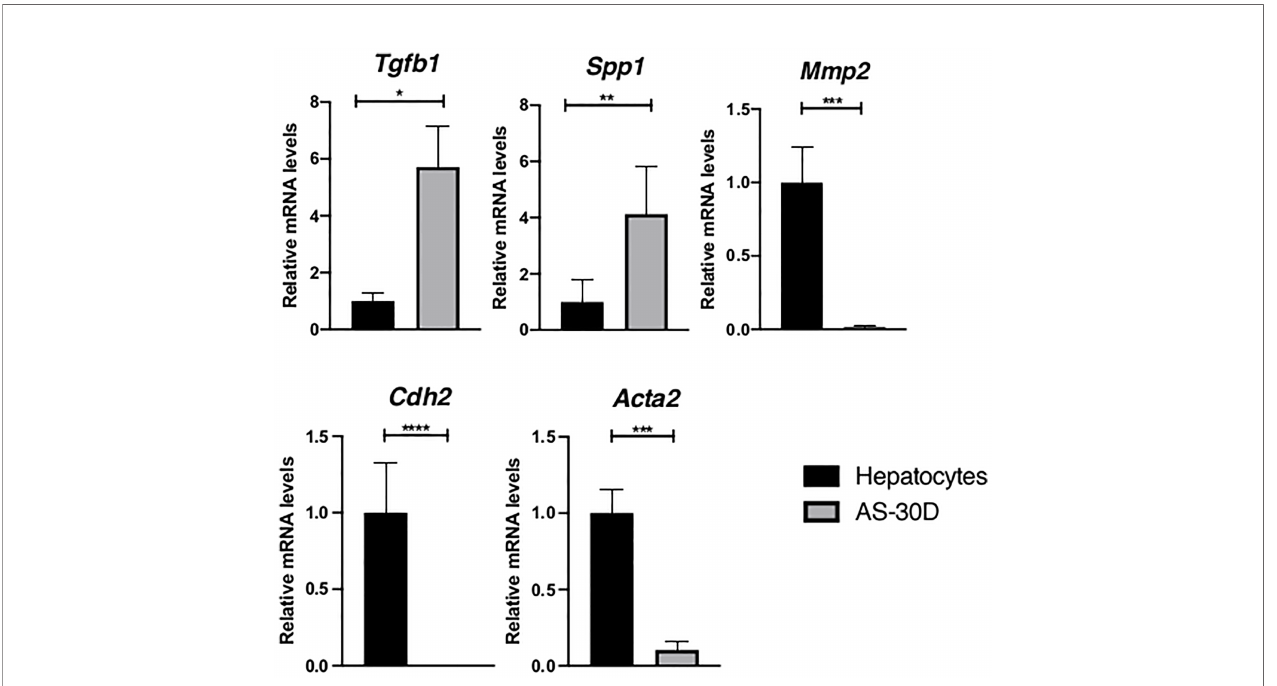
FIGURE 4 | Expression of genes encoding EMT markers in rat hepatocytes and AS-30D cells. Rat hepatocytes were freshly isolated, and AS-30D samples were obtained from cells from the ascitic fl uid of experimental rats. Data represented as mean ± SD. *p-values ≤ 0.05; **p ≤ 0.01; ***p ≤ 0.001; and ****p ≤